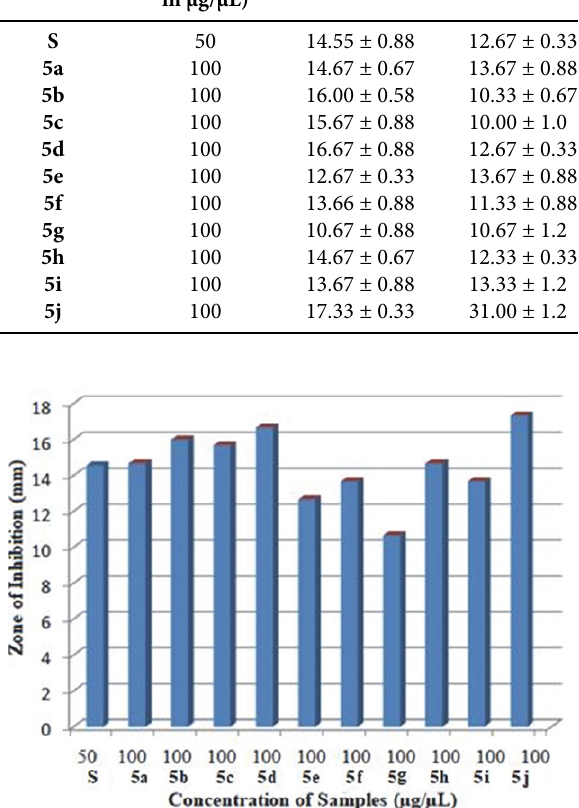
Figure 5. Antibacterial activity of acyl thioureas against E.